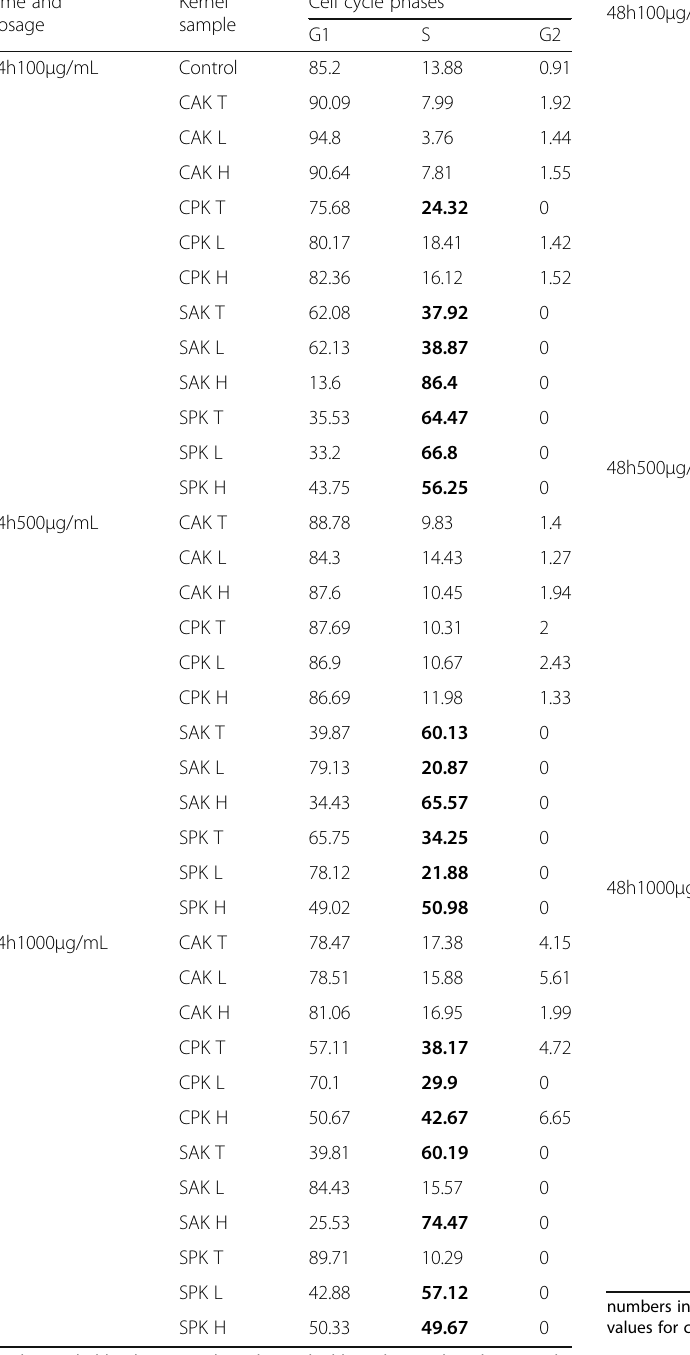
Table 1 The percentage distribution of the control and CAK, Table 2 The percentage distribution of the control and CAK, CPK, CPK, SAK and SPK treated HT-29 cells after 24 h. The SAK and SAK and SPK treated HT-29 cells after 48 h. The SAK and SPK SPK extracts caused an outspoken increase in the percentage of extracts caused an outspoken increase in the percentage of cells cells that arrested in the S-phase of the cell cycle indicating a that arrested in the S-phase of the cell cycle indicating a higher higher mean ± SD as compared to the CAK and CPK exposed mean ± SD as compared to the CAK and CPK exposed cells cells. CPK extracts induced its highest percentage of cells in the S-phase at a concentration of 1000 μ g/mL Time and Kernel Cell cycle phases dosage sample